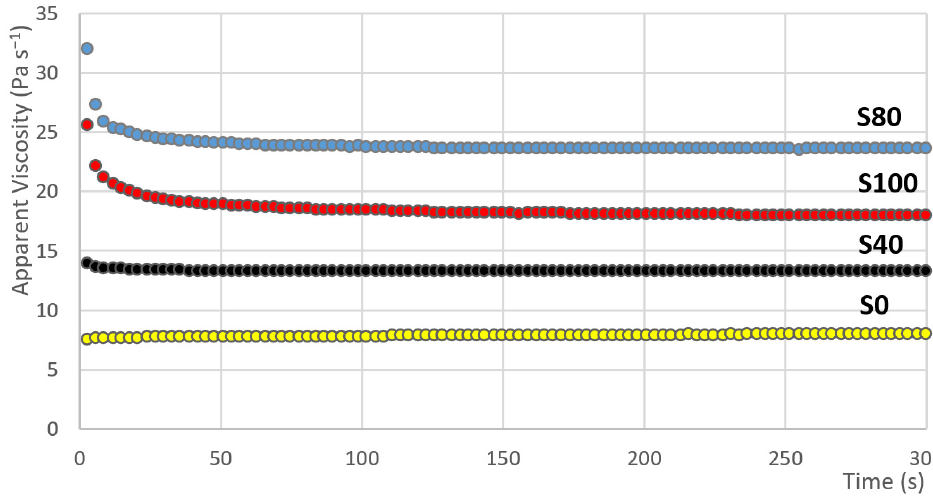
Figure 5. The dependence of the apparent viscosity on the time (samples: S0, S10, S40, S60). The results of these data are evident from Table 4. As in the case of parameter n , the change of parameter φ is, at first, gradual, then the largest change occurs between samples S40 and S60 (see Figure 6). The change is 13% here (the second highest change is 9%). The Low data variability is also evident, where the value of the variation coefficient ranges from 0.4 to 5.8%. Table 4. Exploratory data analysis of the φ values.